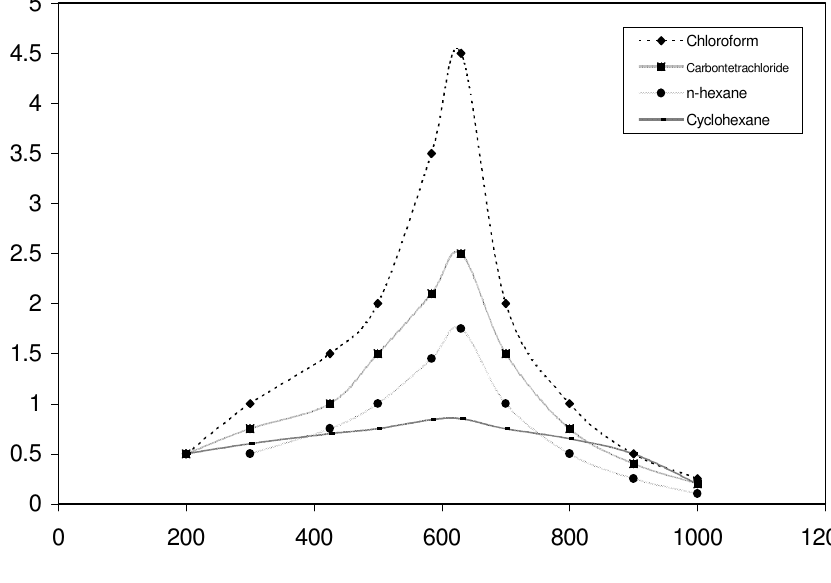
Fig.2 : Absorption spectrum of DETP - Gention violet